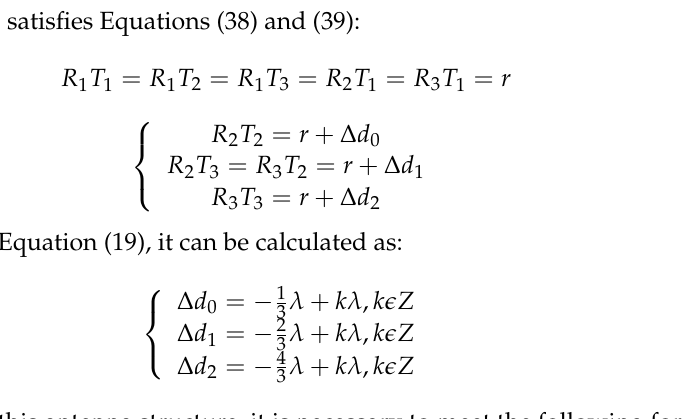
Figure 5. Circular arc 3 × 3 transceiver antenna array. In Figure 5, 𝑇 (cid:2869) , 𝑇 (cid:2870) , and 𝑇 (cid:2871) are transmitting antennas. 𝑅 (cid:2869) , 𝑅 (cid:2870) , and 𝑅 (cid:2871) are receiving antennas. The antennas 𝑇 (cid:2870) , 𝑇 (cid:2871) , 𝑅 (cid:2870) , and 𝑅 (cid:2871) form a parallelogram. 𝜃 is the central angle of the circle with radius 𝑟 of 𝑇 (cid:2869) , where 𝑟 is the distance between the transmitting and receiving antennas.